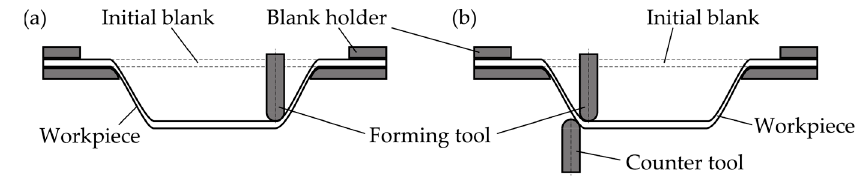
Figure 1. ( a ) Single-point (SPIF) and ( b ) double-sided incremental forming (DSIF)